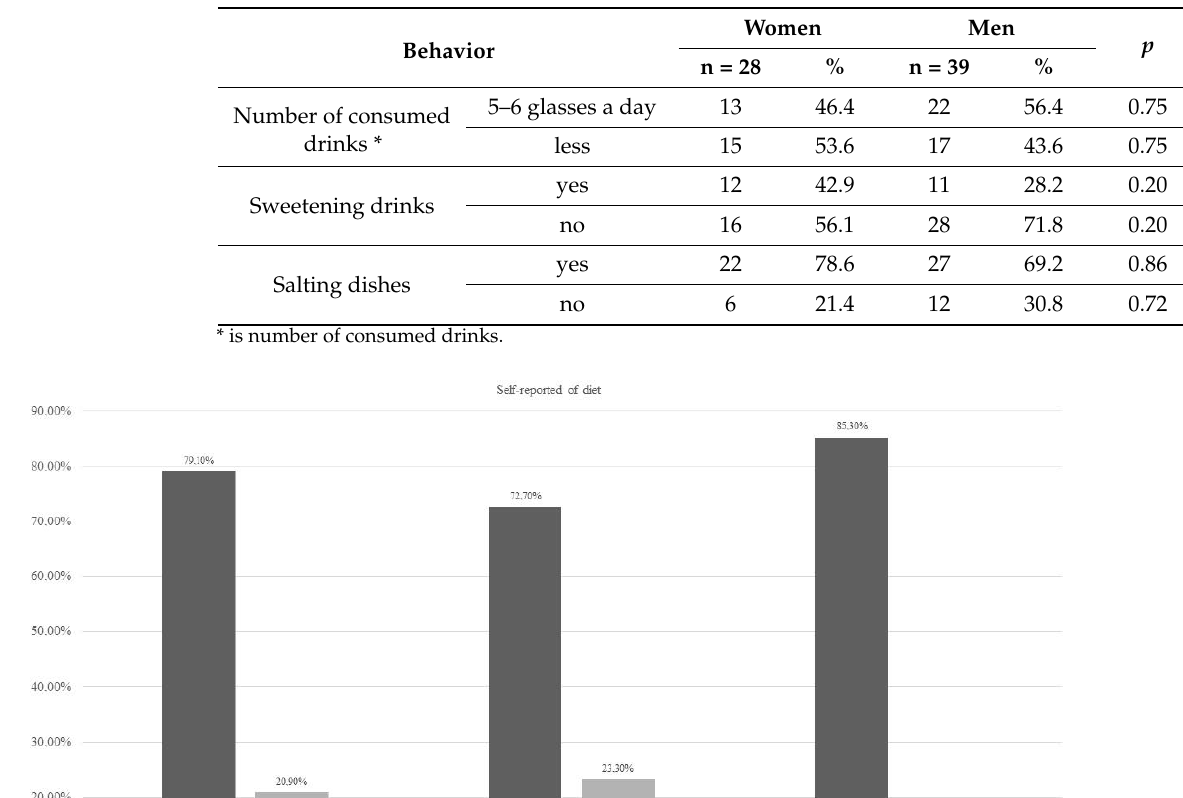
Table 8. Selected dietary behaviors in the study group by gender (n = 67). * except milk.